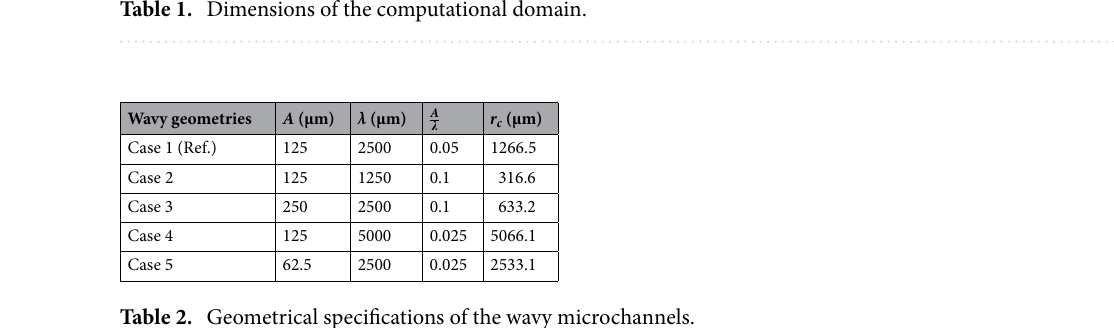
Table 2. Geometrical specifications of the wavy microchannels.